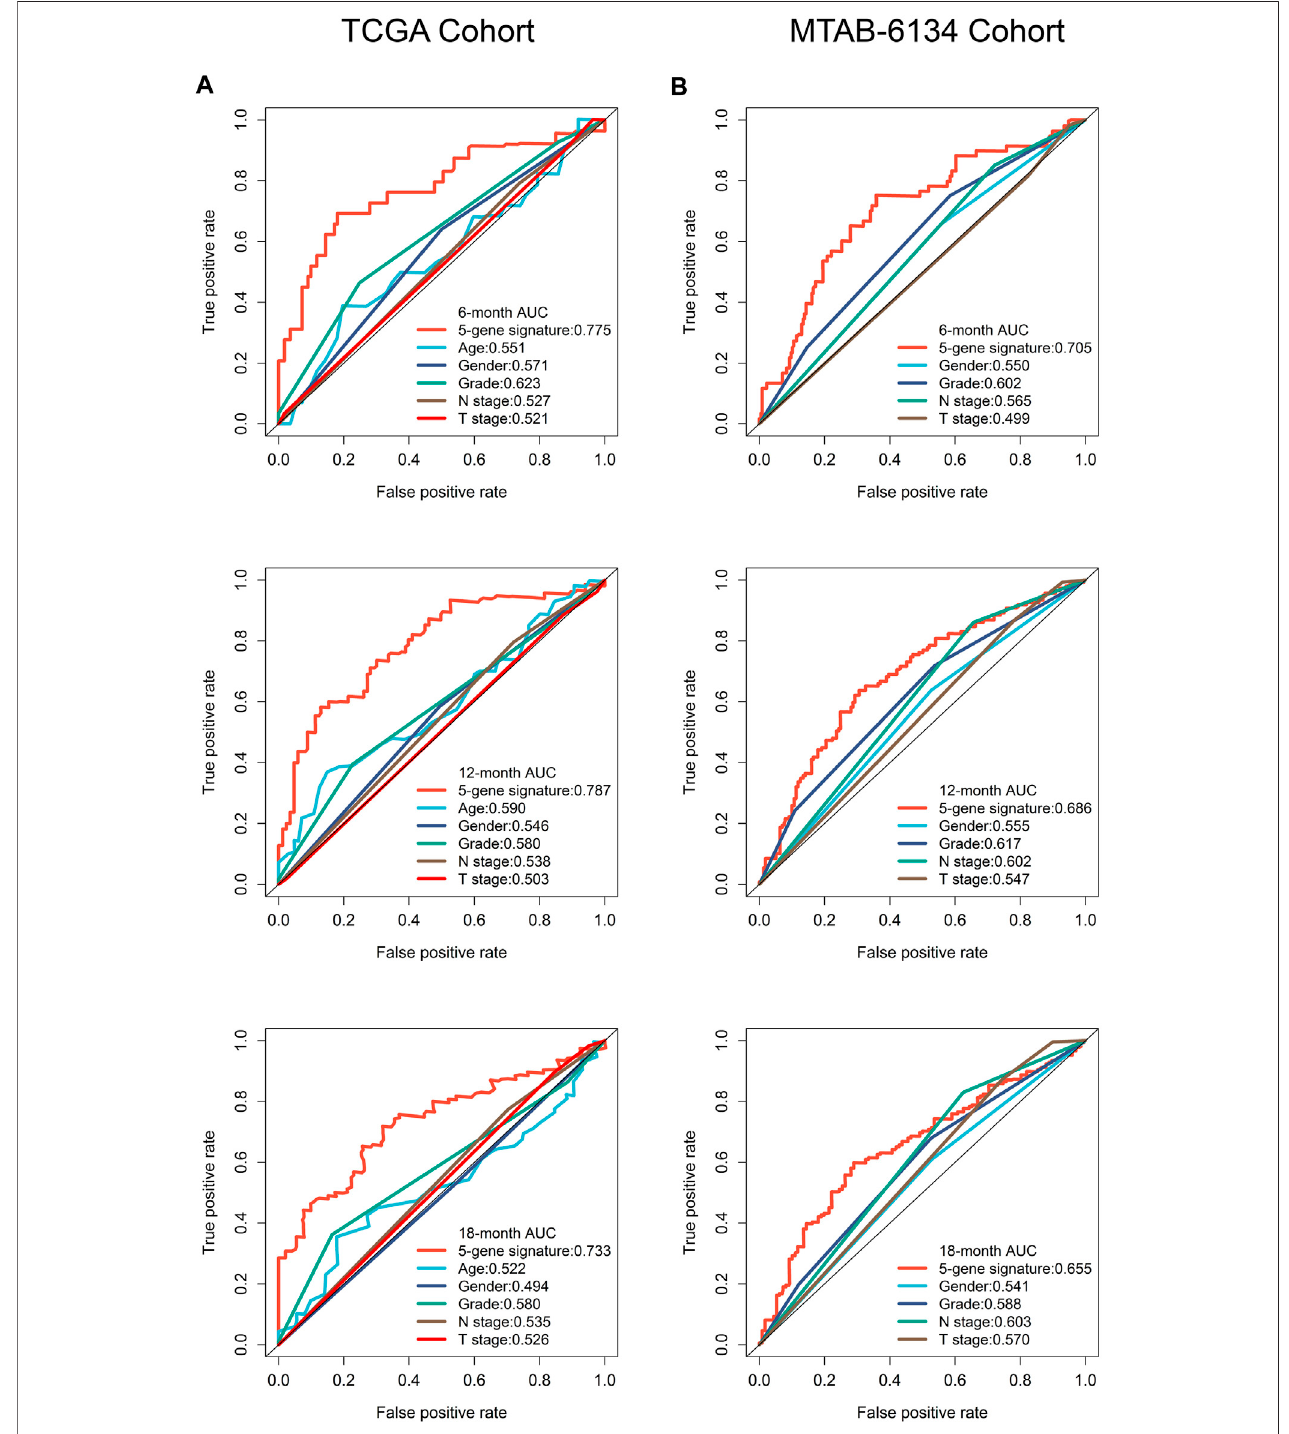
FIGURE 5 | A comparison of the ferroptosis-related signature with clinical indicators. (A) ROC curves compared the predictive abilities of the prognostic signature and clinical parameters for 6-months, 12-months and 18-months RFS in the TCGA cohort. (B) ROC curves compared the predictive capabilities of the prognostic signature and clinical factors for 6-months, 12-months and 18-months RFS in the MTAB-6134 cohort.